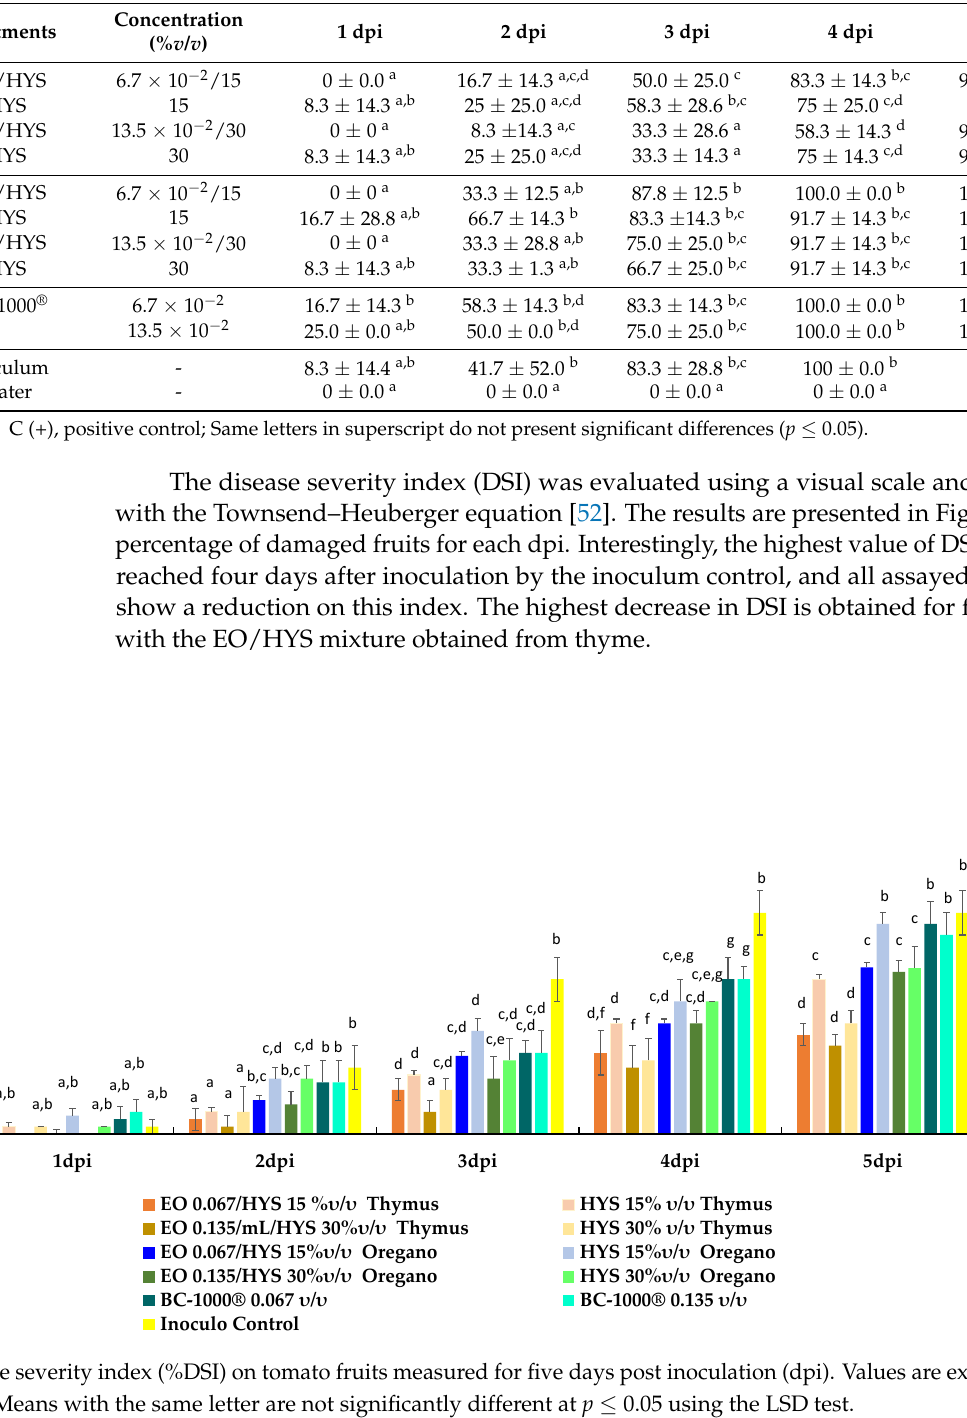
B. cinerea inoculated on tomato fruit. The lowest values of both DIP and DSI were